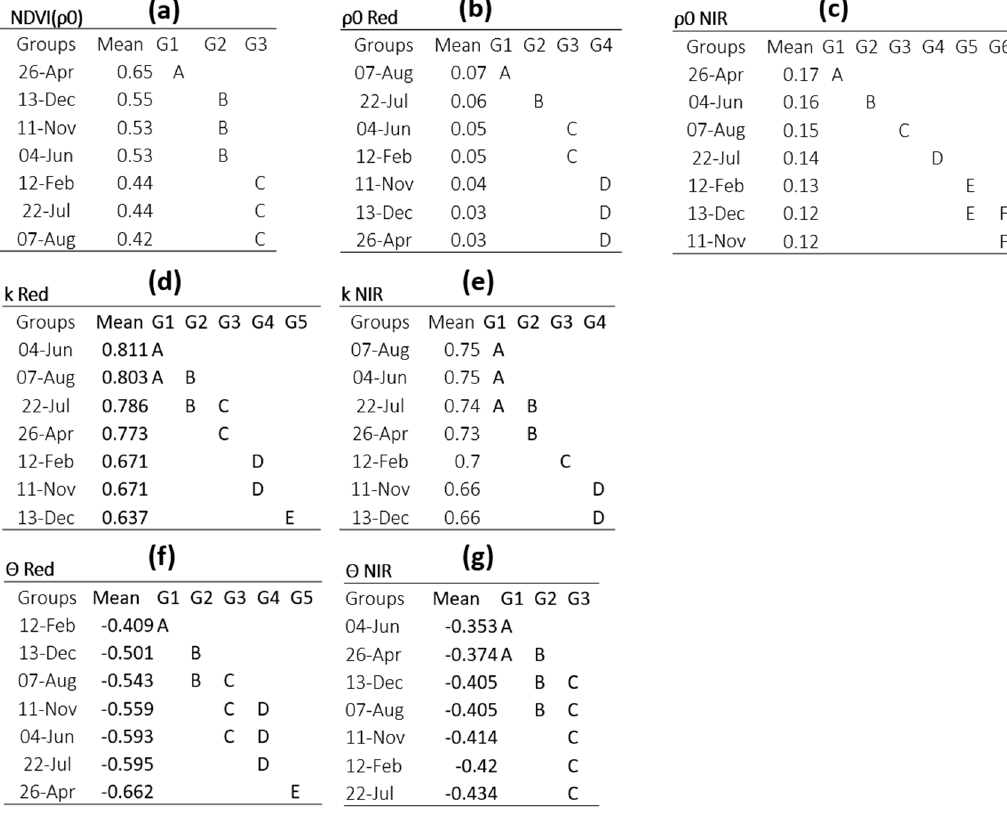
Figure 6. Results from the pairwise Tukey post hoc tests to observe if there were statistically parameter-band mean value differences ( p < 0.01) between pairs of MISR orbits captured on different dates. ( a ) NDVI ( ρ 0) post hoc text; ( b ) ρ 0 red post hoc test; ( c ) ρ 0 NIR post hoc test; ( d ) k red post hoc test; ( e ) k NIR post hoc test; ( f ) Θ red post hoc test; and ( g ) Θ red post hoc test.